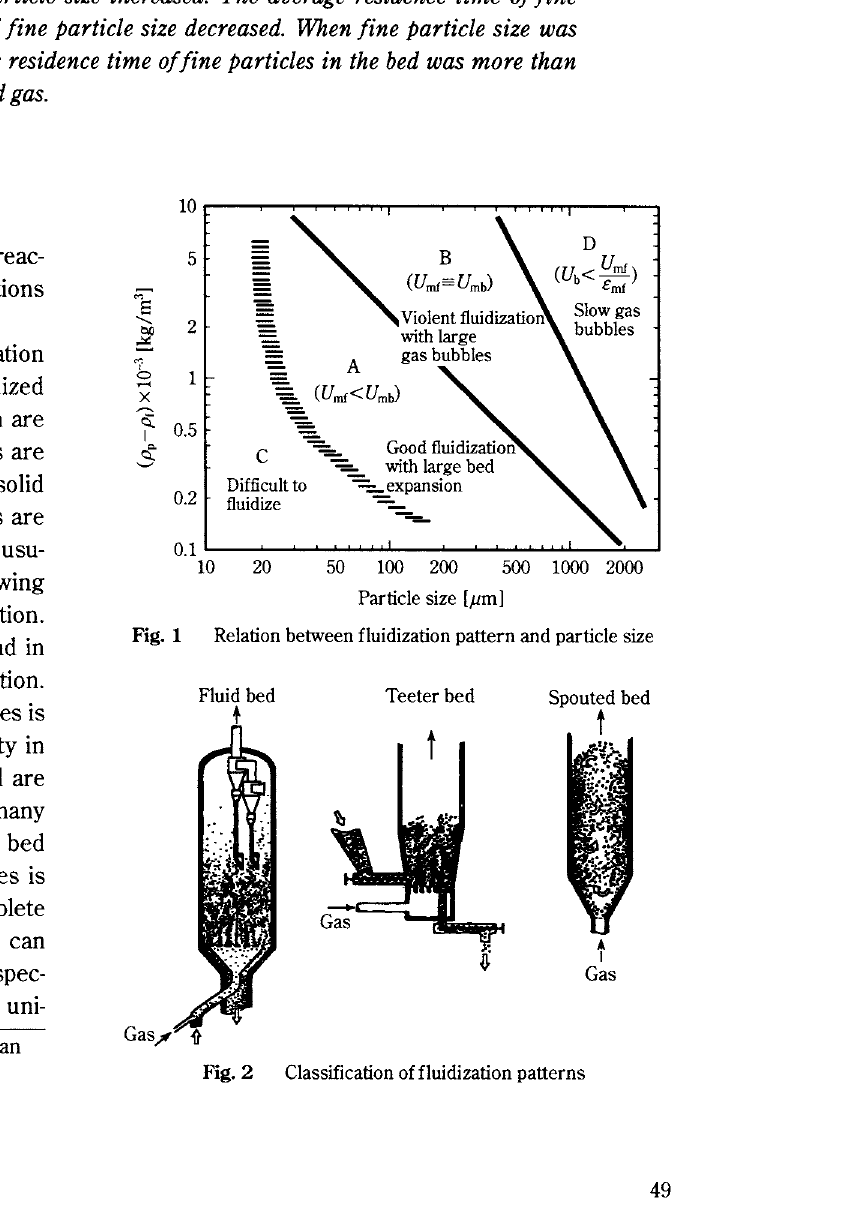
Fig. 2 Classification offluidization